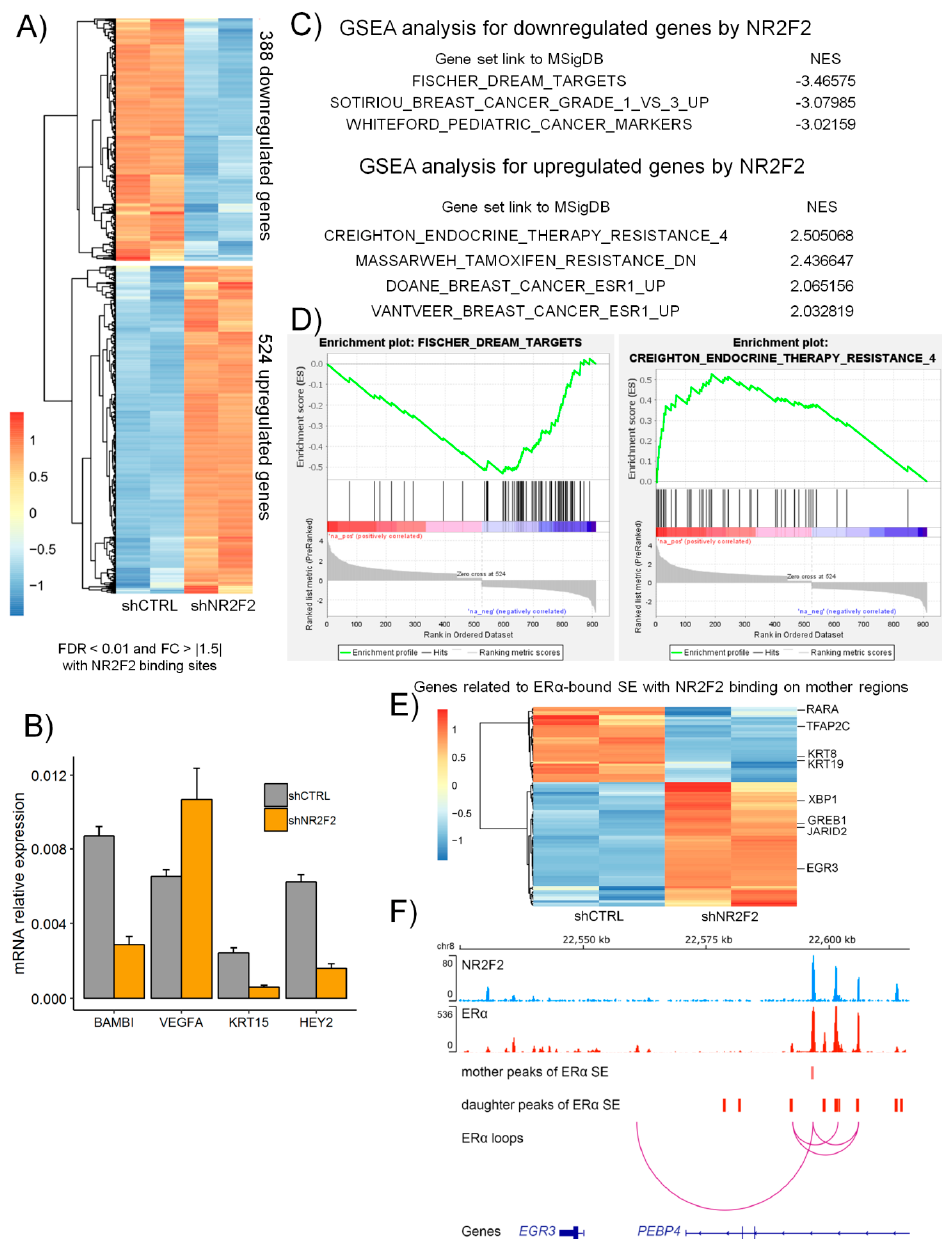
Figure 5. NR2F2 regulated transcriptional programs in breast cancer cells with luminal A subtype. ( A ) RNA-seq heatmap shows the clusters of di ff erentially expressed genes in NR2F2 silenced MCF-7 cells using specific shRNA (shNR2F2). ( B ) RT-qPCR validation shows specific di ff erentially expressed genes in MCF-7 cells. ( C ) Gene set enrichment analysis (GSEA) shows the gene sets that were significantly enriched in NR2F2 silenced MCF-7 cells. NES, normalized enrichment score. ( D ) GSEA plots for specific gene sets. ( E ) RNA-seq heatmap shows the expression levels of genes related to ER α SE with NR2F2 binding on mother regions in control (shCTRL) and shNR2F2 treated MCF-7 cells. ( F ) IGV screenshot shows that NR2F2 and ER α binding sites marked the mother and daughter regions of ER α SE with ER α bound loops at the EGR3